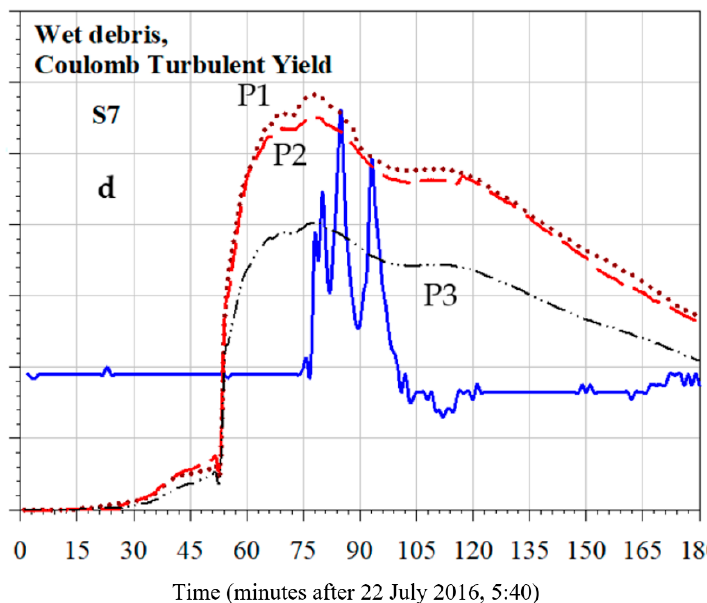
Figure A3. Simulation S7.